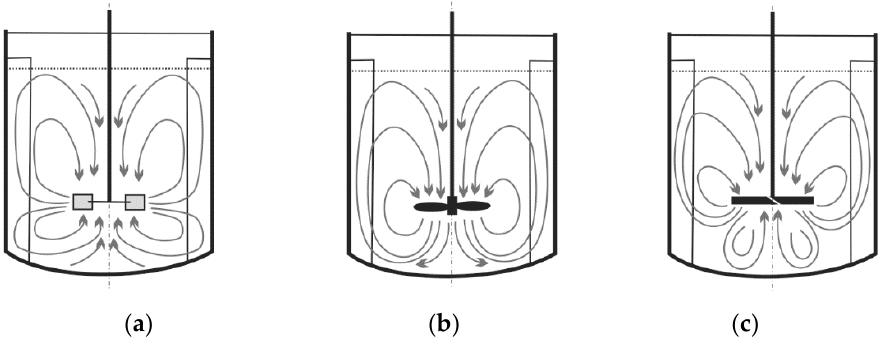
Figure 1. Flow motion generated by different impellers types: ( a ) radial; ( b ) axial; ( c ) mixed.